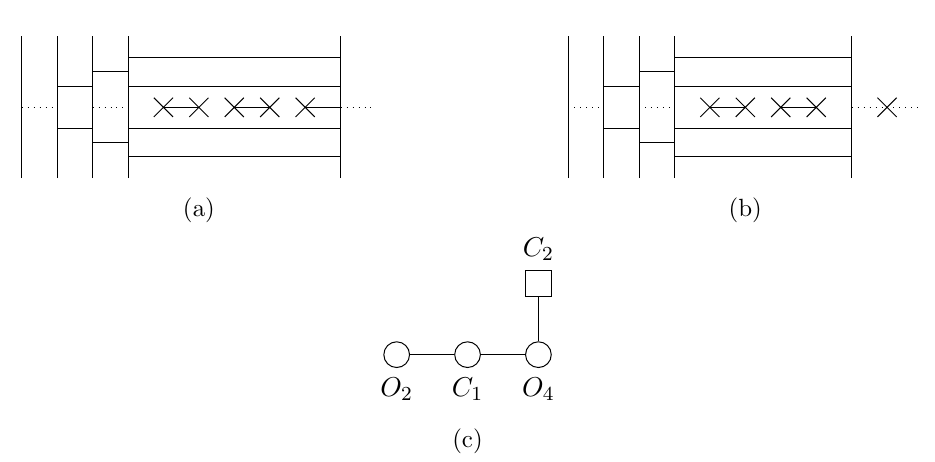
Figure 30. Orthosymplectic model with n s = n d = 5, ~ l d = (5 ; 3 ; 5 ; 3 ; 5), ~ l s = (1 ; 1 ; 1 ; 1 ; 1) and rightmost orientifold plane g O 3 + . (a) Coulomb branch brane con(cid:12)guration. (b) Resulting model after the collapse transition has been performed in (a), in order to being able to read the quiver. (c) Quiver that can be read from the brane system (b). The Higgs branch of this model is the closure of the maximal nilpotent orbit of sp (2), corresponding to partition (cid:21) = (4): M H = (cid:22) O